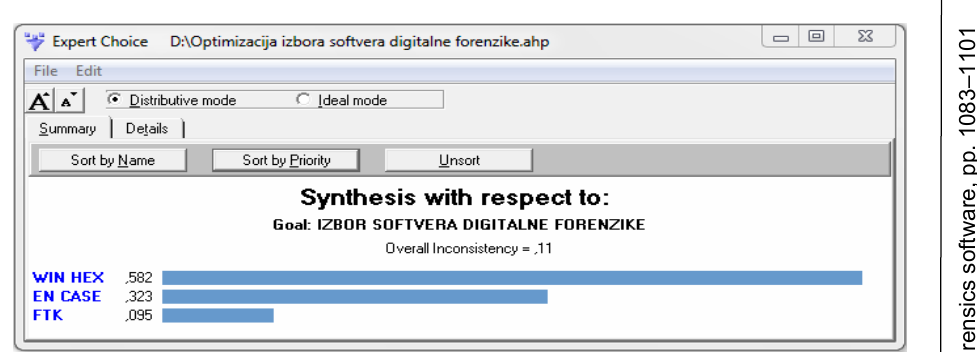
Figure 6 – Graph of the anticipated alternatives in relation to the objective Рис . 6 – Диаграмма предполагаемых альтернатив цели Slika 6 – Graf o č ekivanih alternativa u odnosu na cilj